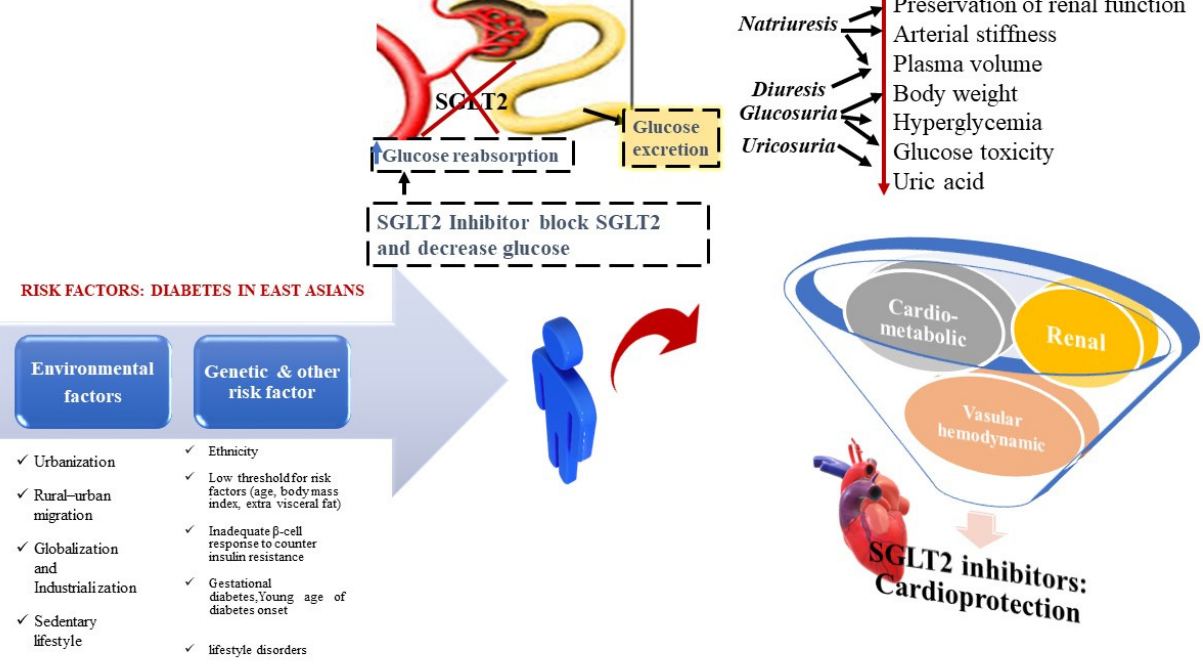
Figure 3. Effects of SGLT2 inhibitors on Type 2 diabetes mellitus and cardiovascular system.